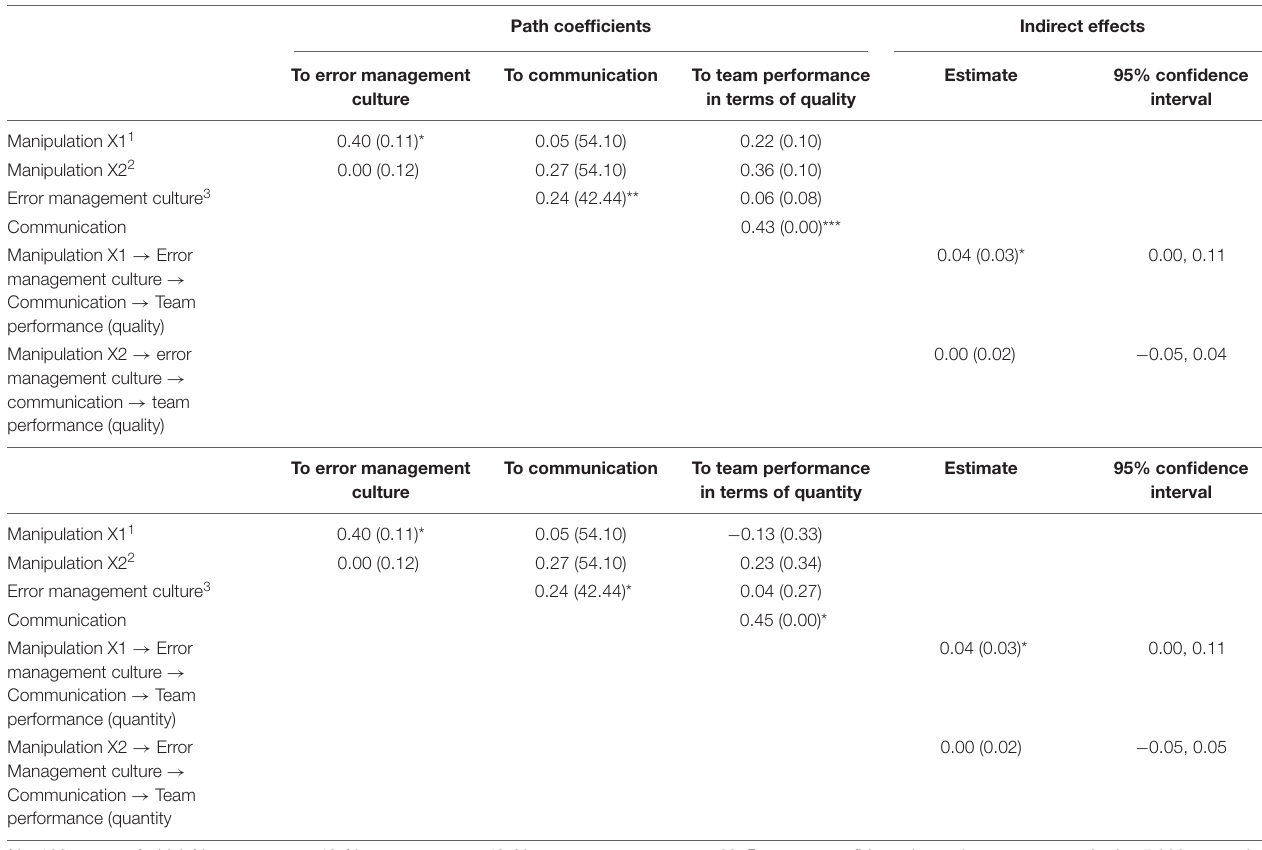
TABLE 9 | Serial mediation analysis with communication in Study